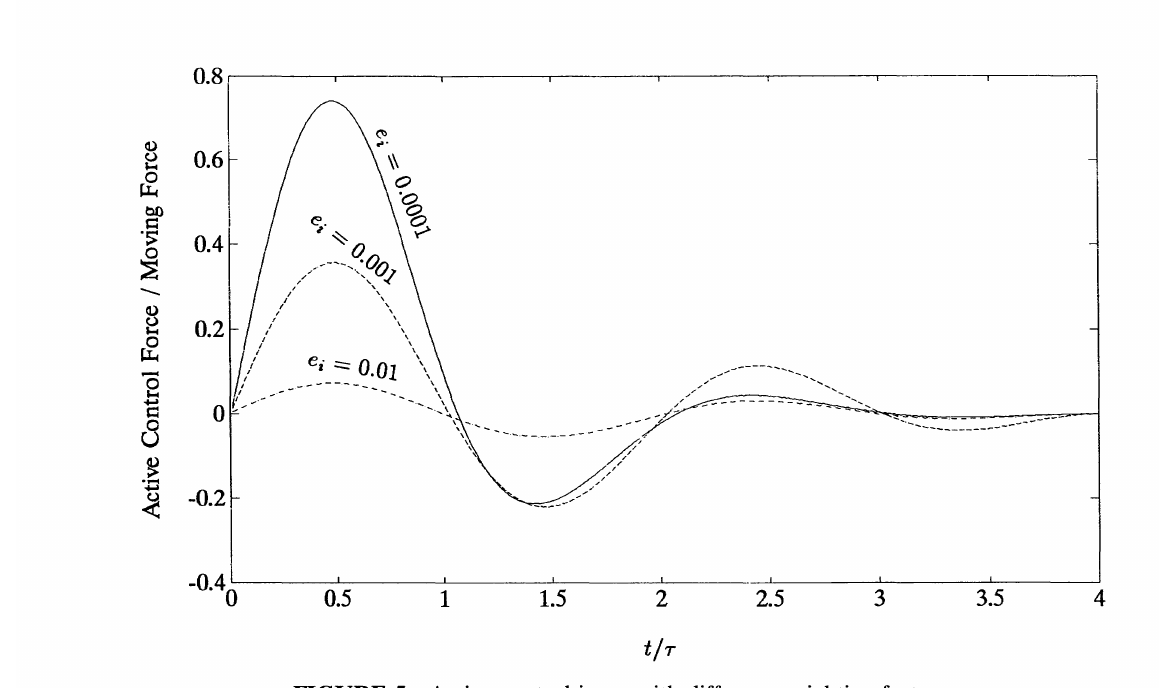
FIGURE 5 Active control input with different weighting